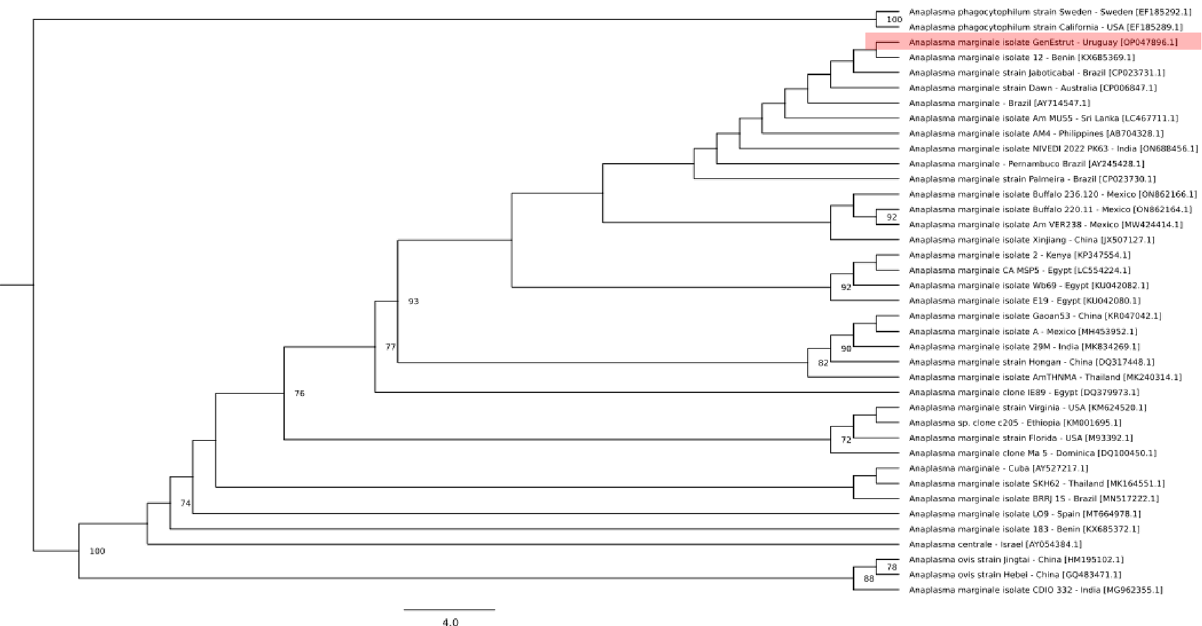
Figure 1. Characterization of the A. marginale partial msp5 sequence. The tree was constructed using the maximum likelihood method with the evolutionary model K2P + G4. The numbers in the tree indicate bootstrap values for the branch nodes. Sequences of A. phagocytophilum were used as